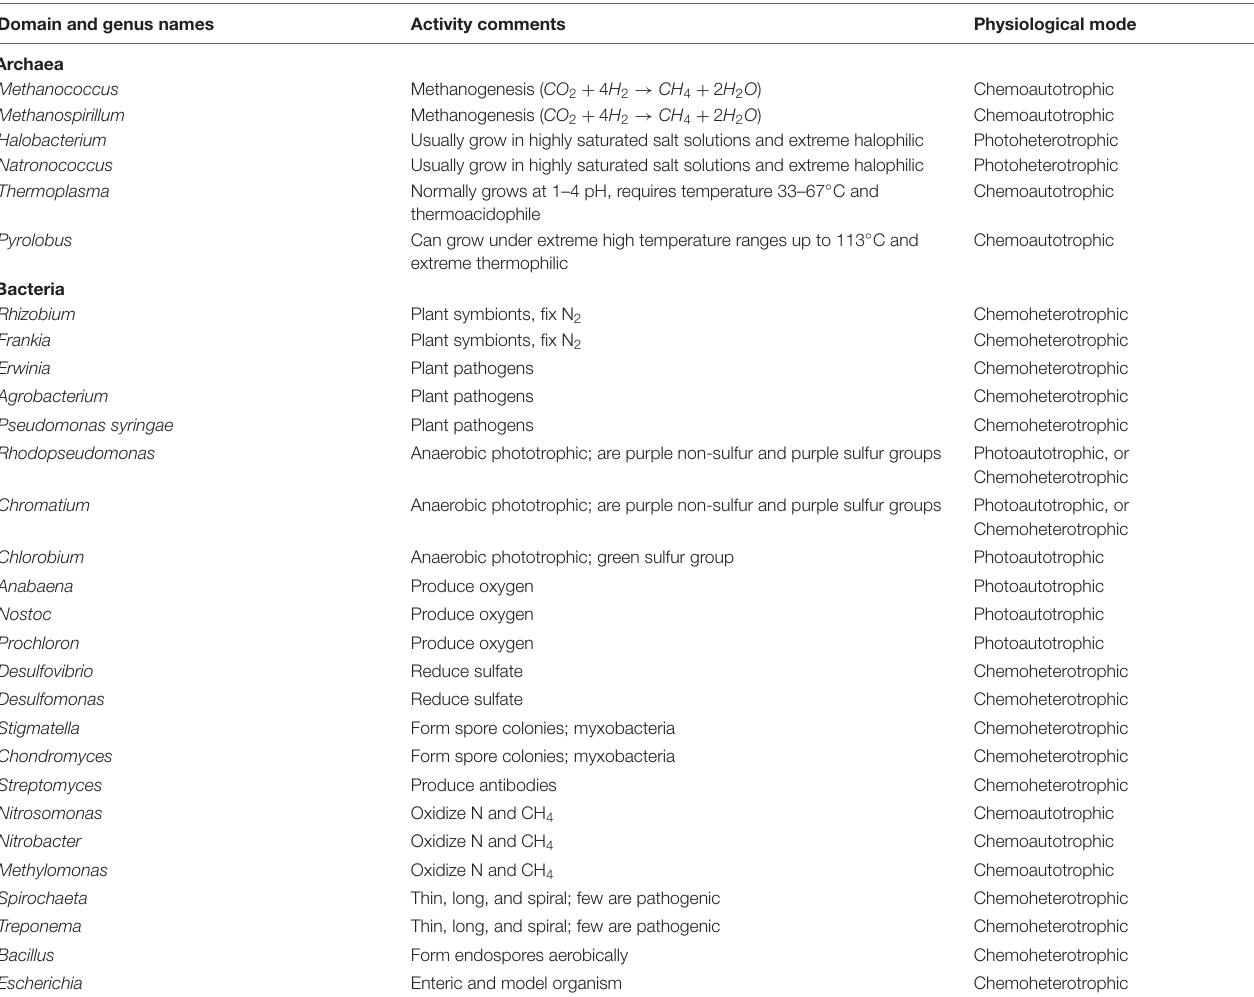
TABLE 1 | Details of some archaeal and bacterial strains, their phylum names, and ecophysiological